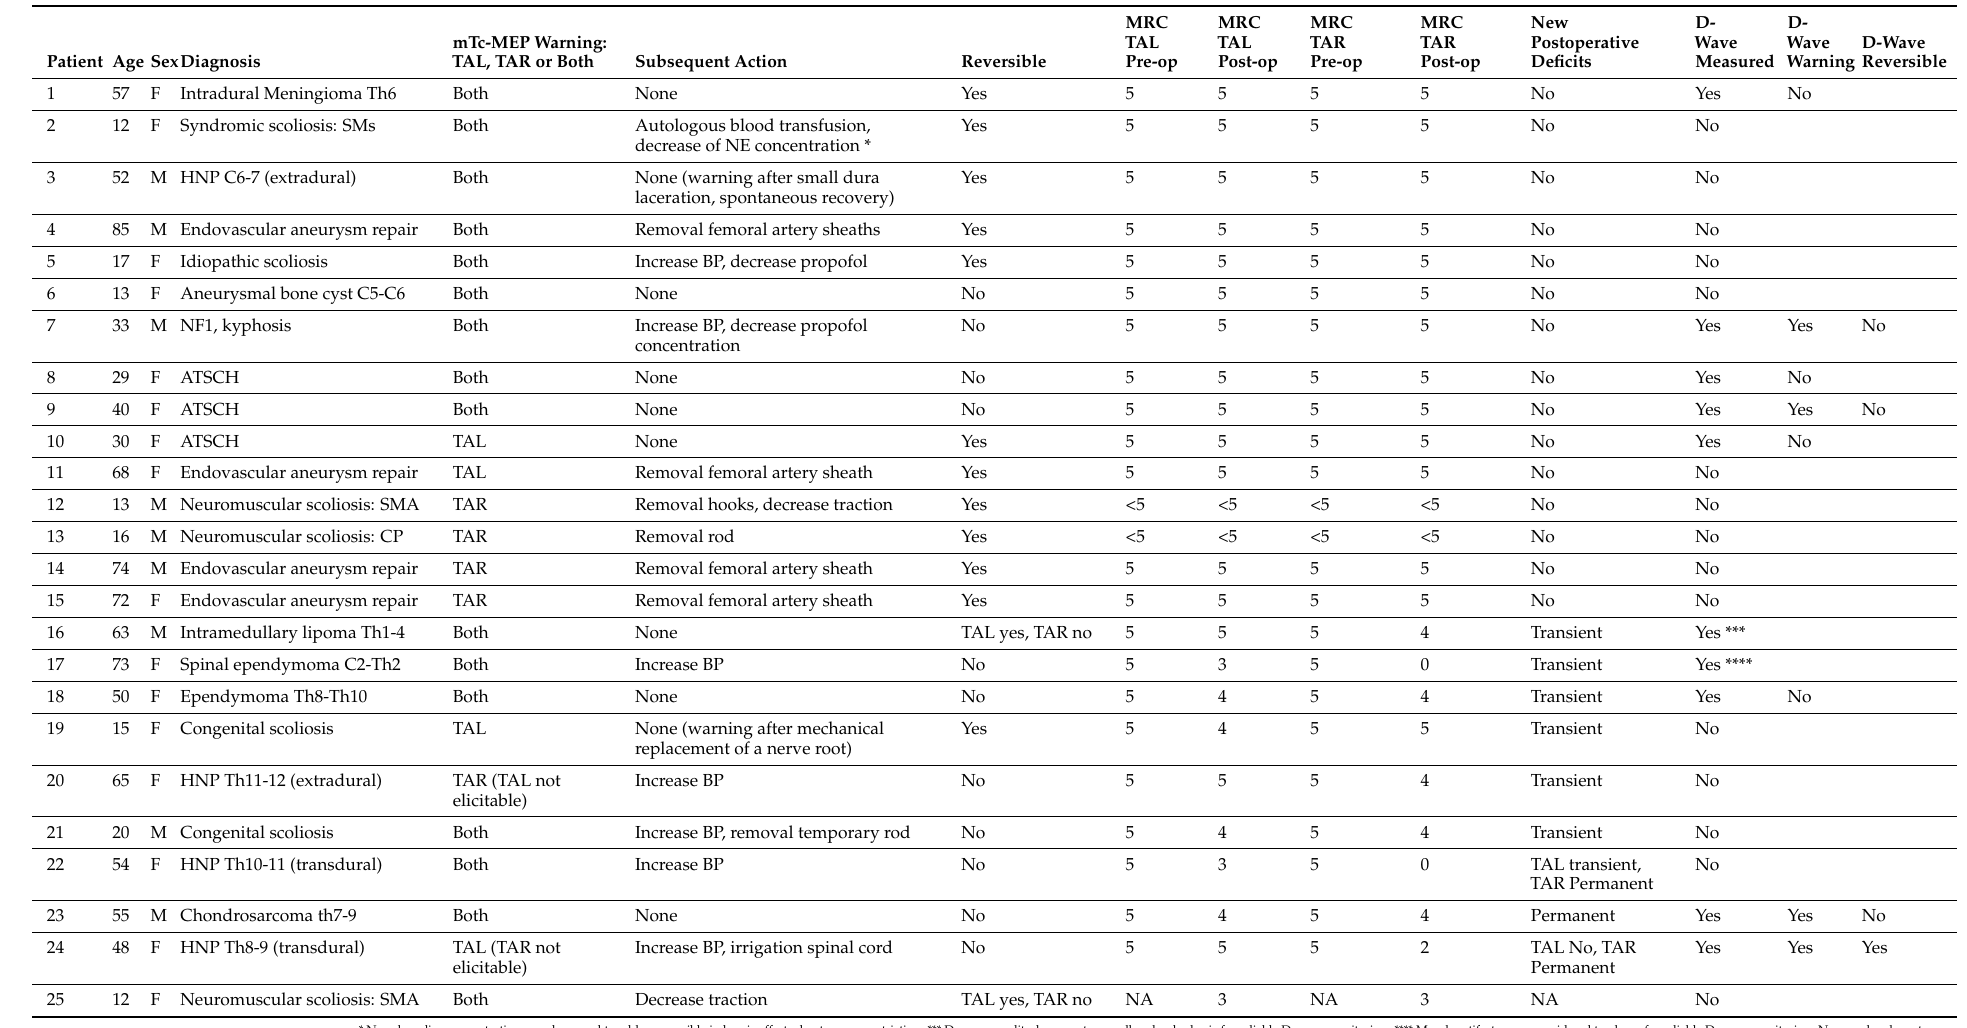
Table 4. Patient characteristics of the 25 patients that had a warning for the left and/or right